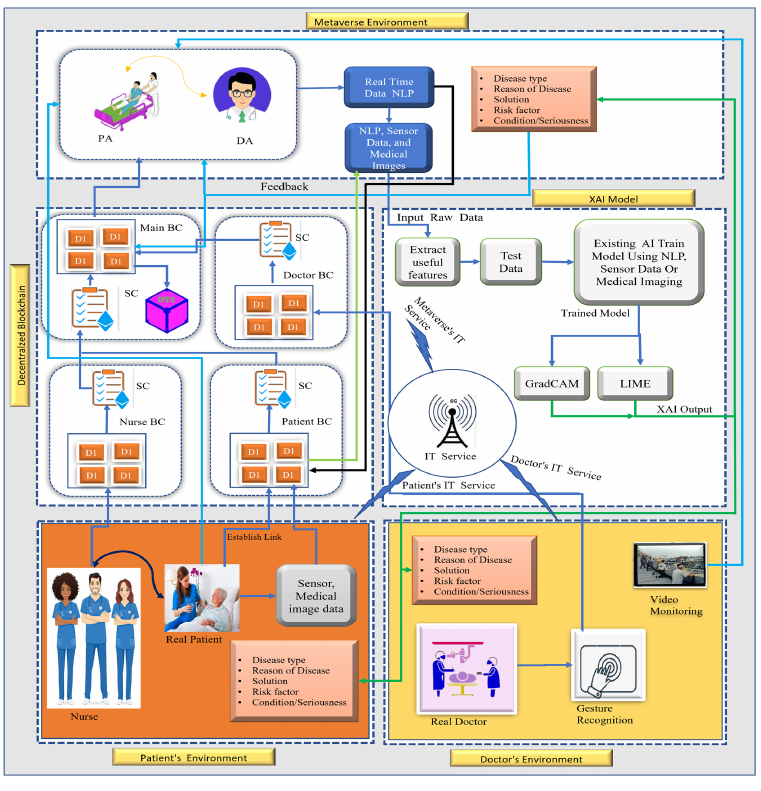
Figure 2. The architecture of the healthcare metaverse. Note : DA denotes doctor’s avatar, PA: patient avatar, CG: caregiver avatar, BC: blockchain, SC: smart contract, VH: virtual hospital, and OT: operating theatre.